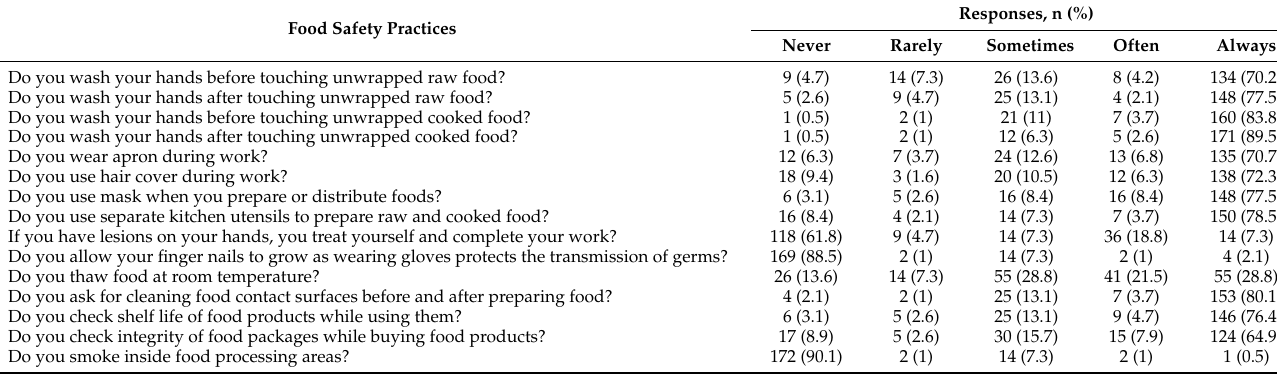
Table 4. Summary of questions and responses for assessment of food safety practices of food handlers working at hospitals in Bangladesh (N =